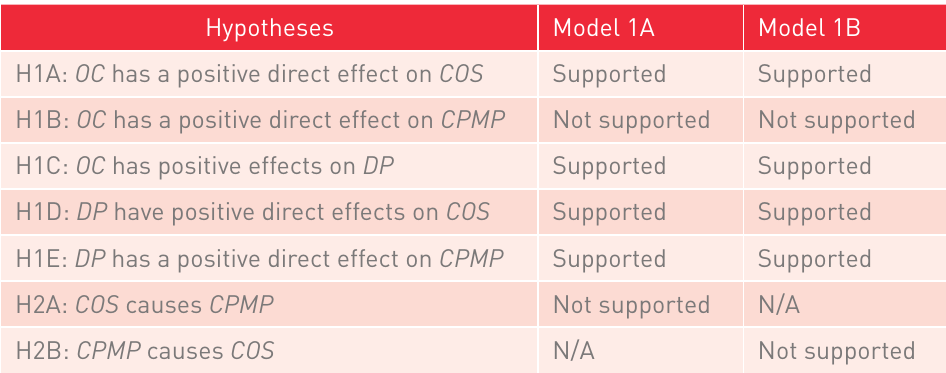
Results of hypothesis tests Hypotheses